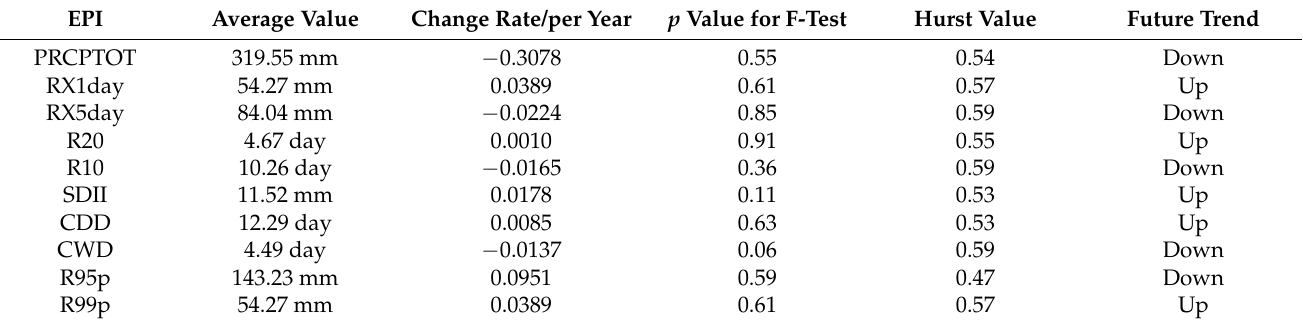
Table 4. Statistic of change trend of each EPI within Hubei province in spring during 1960 – 2019.